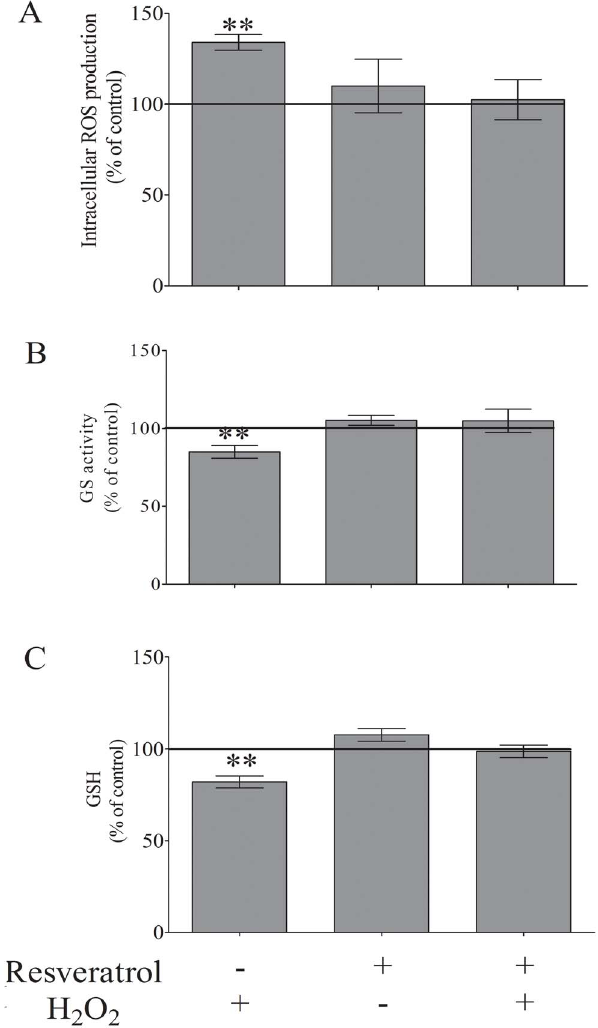
Figure 7. The effect of resveratrol on (A) intracellular ROS production, (B) GS activity and (C) intracellular GSH content during H 2 O 2 -induced oxidative insult. The culture medium was removed followed by the addition of DMEM/F12 supplemented with 5% FBS, and the cells were pre-incubated for 1 h with 100 m M resveratrol followed by the addition of 50 m M H 2 O 2 for 3 h. Absolute values obtained under control conditions were 2.2 6 0.6 m mol/mg protein/min for GS activity and 14 6 1.1 nmol/mg protein for GSH content. The data represent the mean 6 S.E. from 4 to 6 experimental determinations performed in triplicate. ** P , 0.01 indicates significant differences from the control values.